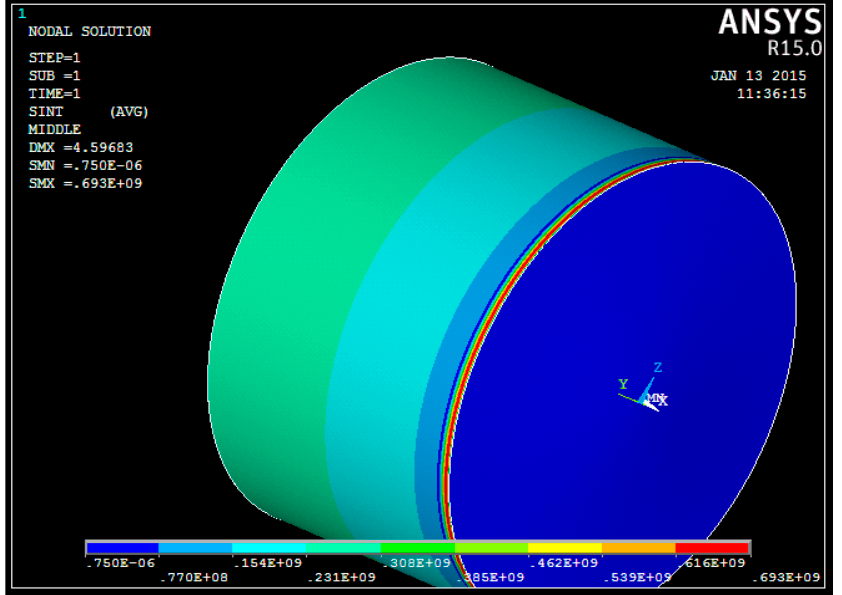
Figure 14. The results of calculating the equivalent stresses of the middle tank surface with a constant wall thickness [42].